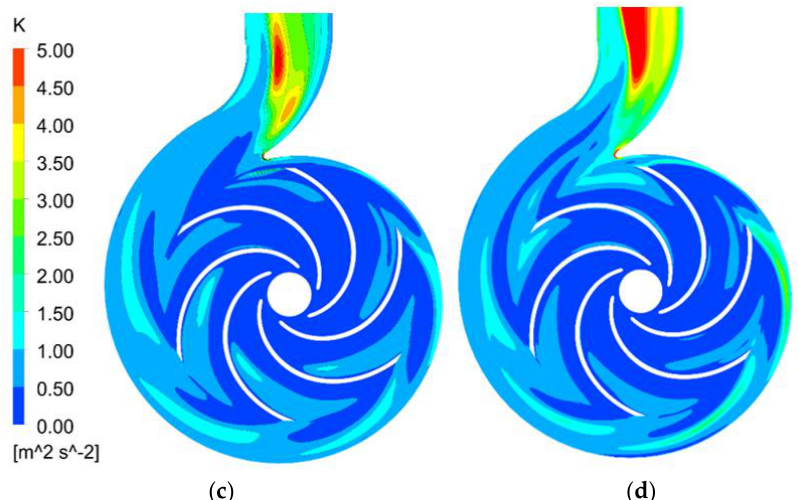
Figure 15. Turbulent kinetic energy distribution in axial plane b under different flow rates. ( a ) 0.6 Q d , ( b ) 0.8 Q d , ( c ) 1.0 Q d , ( d ) 1.2 Q d .